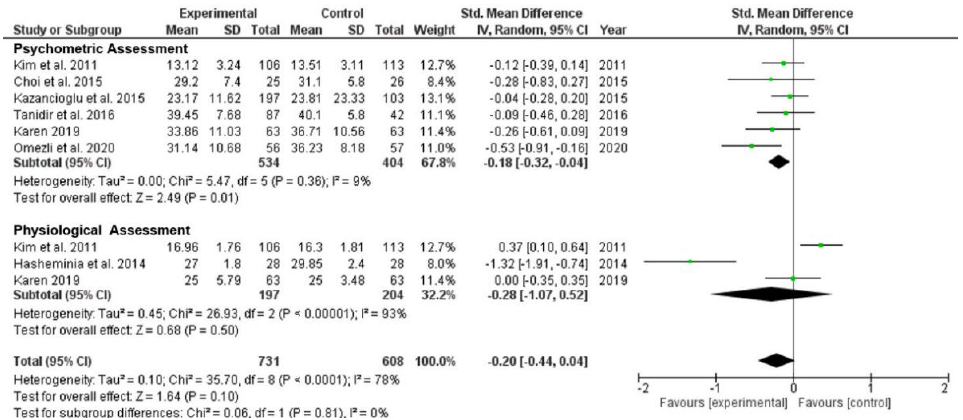
Figure 5. Forest plot of comparison: sub-group analyses—change in anxiety level between groups with psychometric assessments and physiological assessments after third molar extraction [15,35,37,38,40,43,46].